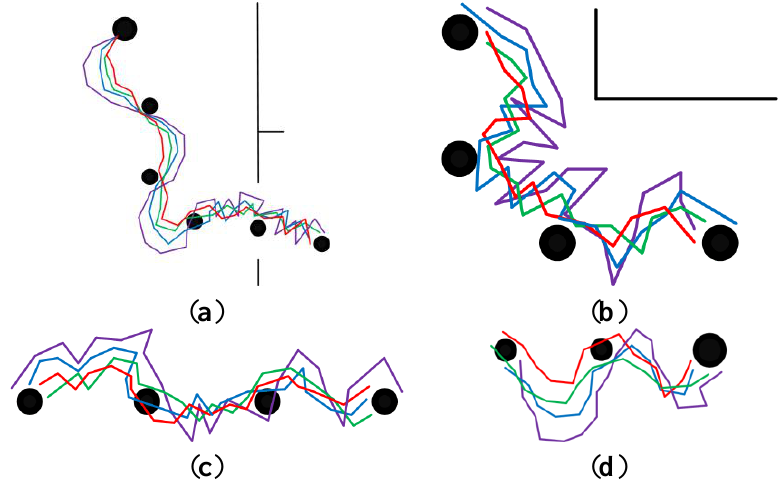
Figure 9. The homing trajectories in non-modified environments with relatively poor illumination. ( a – d ) show the results obtained in phase 1, 2, 3 and 4, respectively. Red lines correspond to the proposal. Violet lines correspond to SURF. Blue lines correspond to the proposal without selection and updating. Green lines correspond to the proposal without updating. In each figure, the robot moves from left to right, the black disks with the same size are intermediate nodes, and the bigger one is starting node or home node.